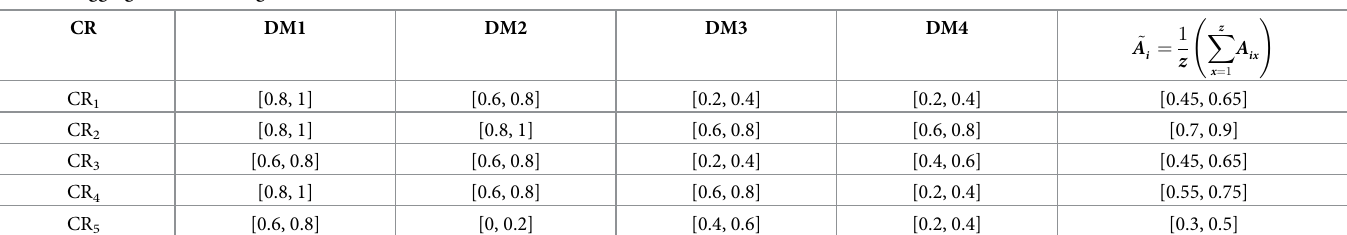
Table 4. Aggregation of the linguistic evaluations of